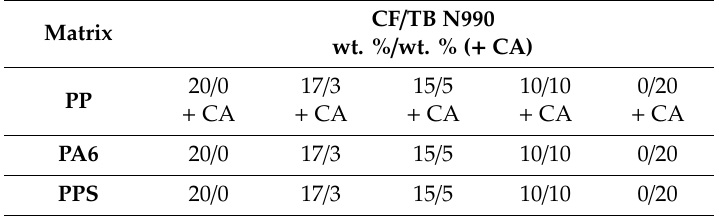
Table 5. Extruded hybrids containing TB N990 and CF; a coupling agent (CA) was used in PP hybrids.